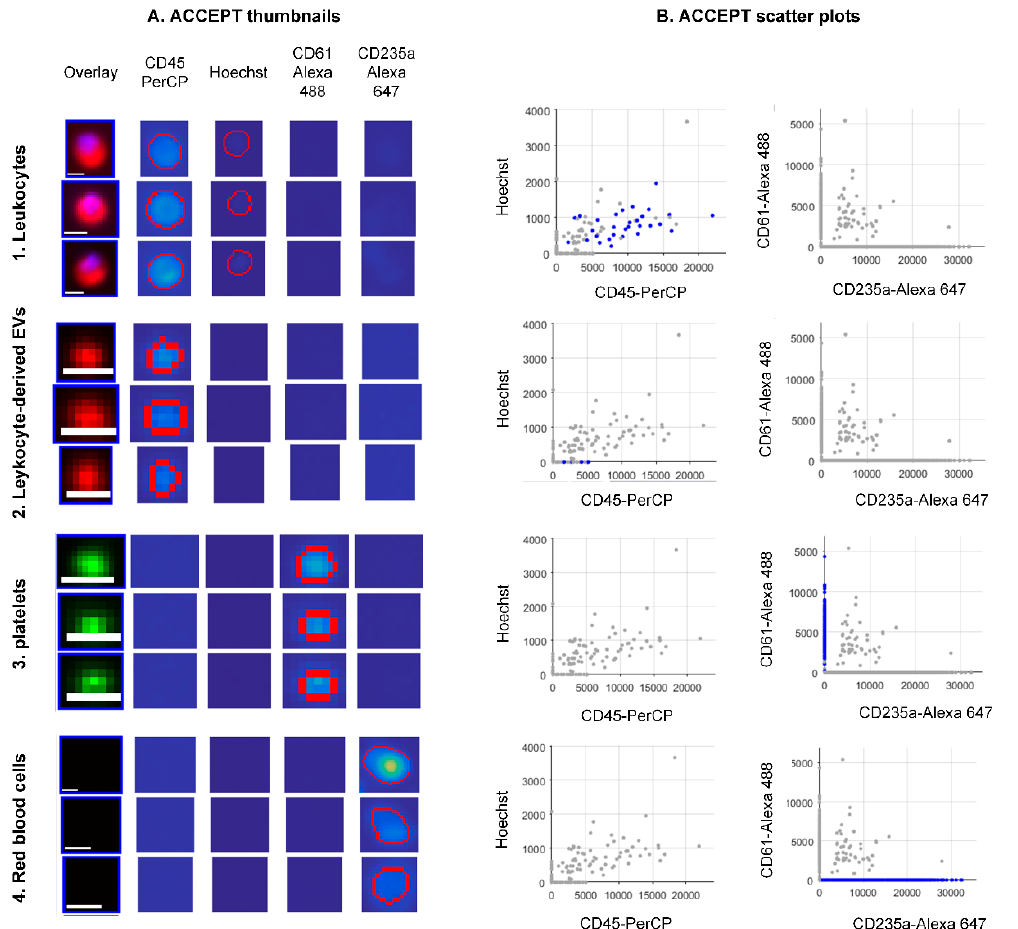
Figure 3. Examples of objects detected in the immunofluorescence image data sets of blood samples without EpCAM enrichment. The objects fall in the ACCEPT gates, the names of which are indicated vertically. Panel ( A ) shows examples of ACCEPT thumbnails. Scale bars indicate 6.4 µ m. Panel ( B ) shows scatter plots of the mean intensity of the Hoechst versus the mean intensity of CD45-PerCP and the mean intensity of CD61-Alexa 488 versus the mean intensity of CD235a-Alexa 647. Blue dots represent single events falling in the respective gate.